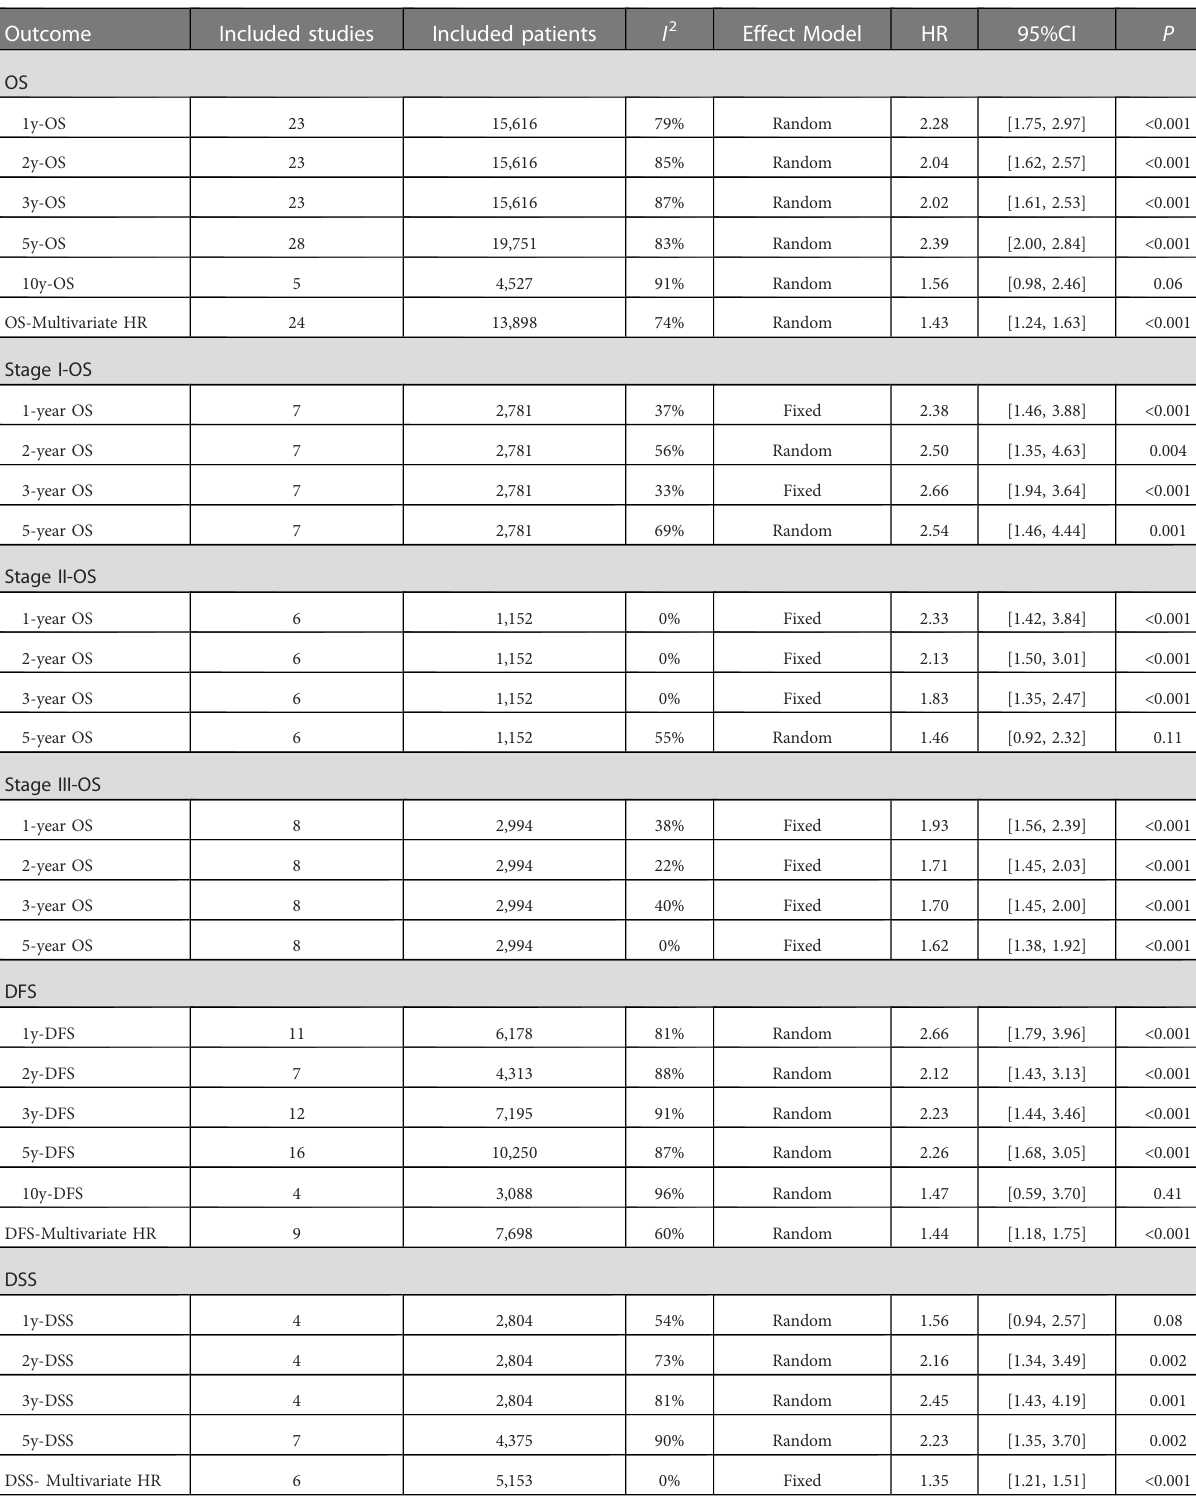
TABLE 4 Survival outcomes of patients between the PBT group and Not-PBT group.